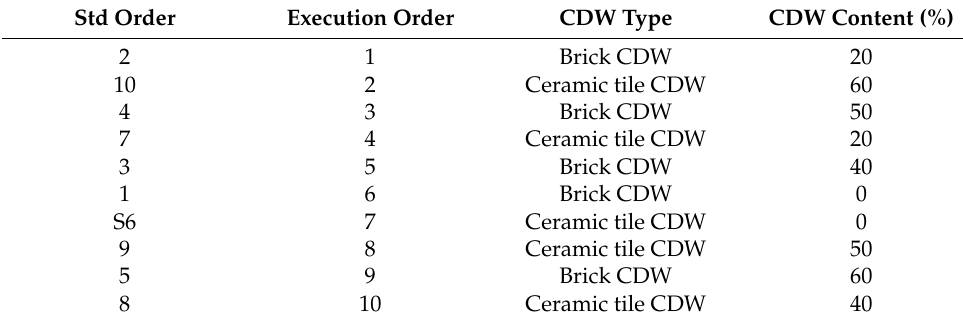
Table 3. Experimental matrix used by CDW type and